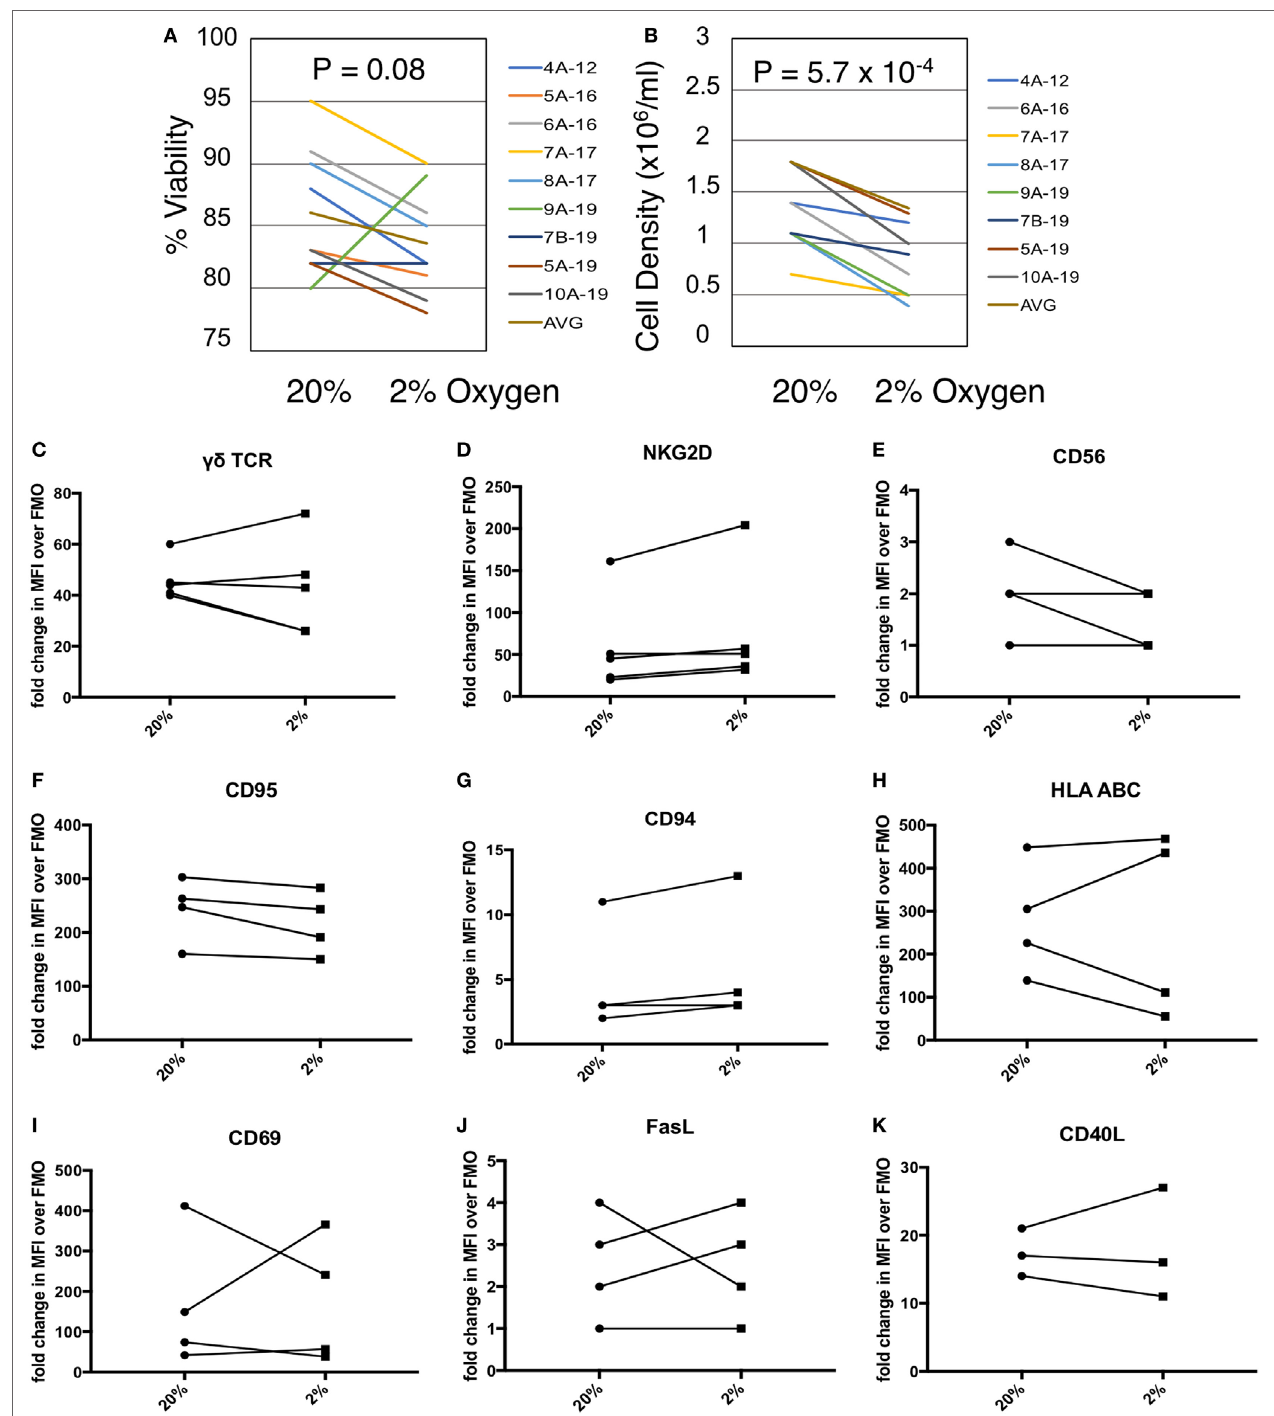
FigUre 2 | Gamma delta T cell ( γδ Tc) viability and proliferation under hypoxia/normoxia differ, but overall surface marker expression is not significantly impacted by oxygen levels. (a) Viability of γδ Tc cultured under 20% versus 2% O 2 for 48 h beginning on culture days 12–19, for eight cultures from seven different donors, assessed via Trypan Blue exclusion. Donor numbers are given with A and B indicating different cultures from the same donor; numbers after the hyphen are the culture days on which the experiment was begun. (B) Cell density assessment from experiment shown in (a) . (c–K) The indicated surface markers were assessed by flow cytometric analysis [ (c,D) n = 5; (e–J) n = 4; (K) n = 3 different donor